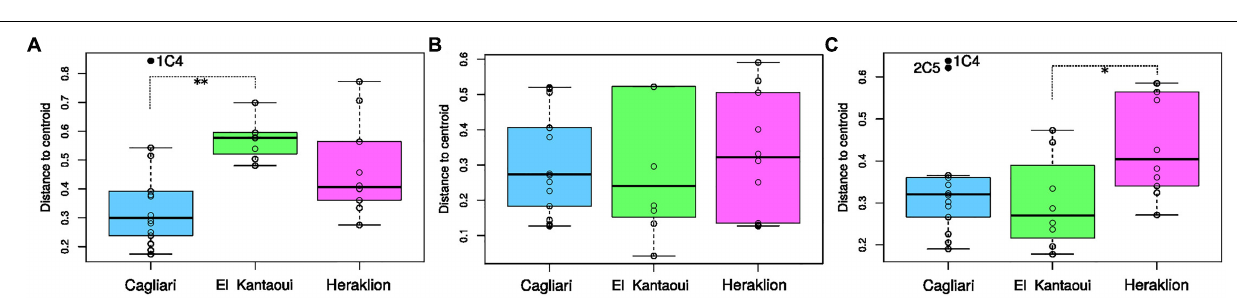
FIGURE 4 | Structure heterogeneity within port estimated as the distance to group centroid of the bacterial (A) , archaeal (B) and SRB (C) communities in surface sediments collected at the ports of Cagliari, El Kantaoui, and Heraklion. Box-and-whisker plots indicate 25–75 percent quartiles (box) and the medians (horizontal line inside each box). Bars are drawn from each box to the higher and lower data within 1.5 times the interquartile range. Values outside the inner fences, outliers, are shown as full black circles. ∗ p < 0.05; ∗∗ p <